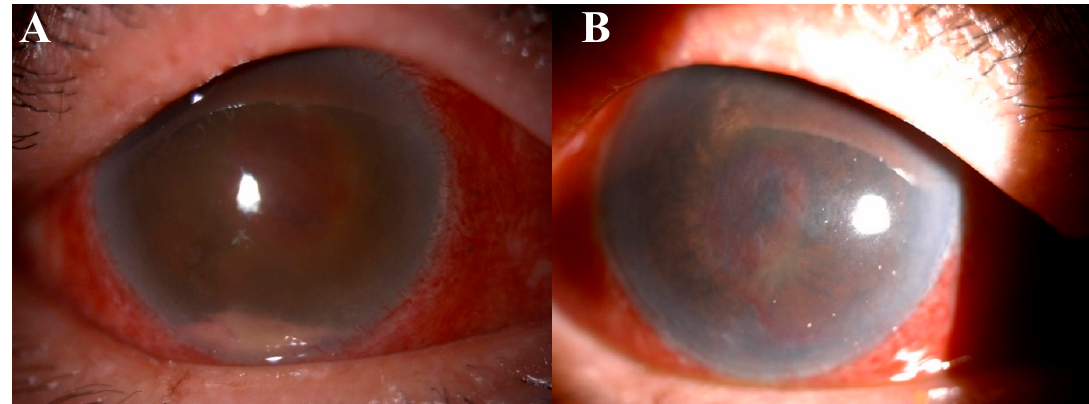
Figure 3. Right eye of patient. ( A ) On 2 May 2017, the patient demonstrated conjunctiva injection, hypopyon in the anterior chamber and yellowish material behind the lens. ( B ) On 30 May 2017, conjunctiva injection was still present after antimicrobial treatments and blood clot obscured the fundus view.